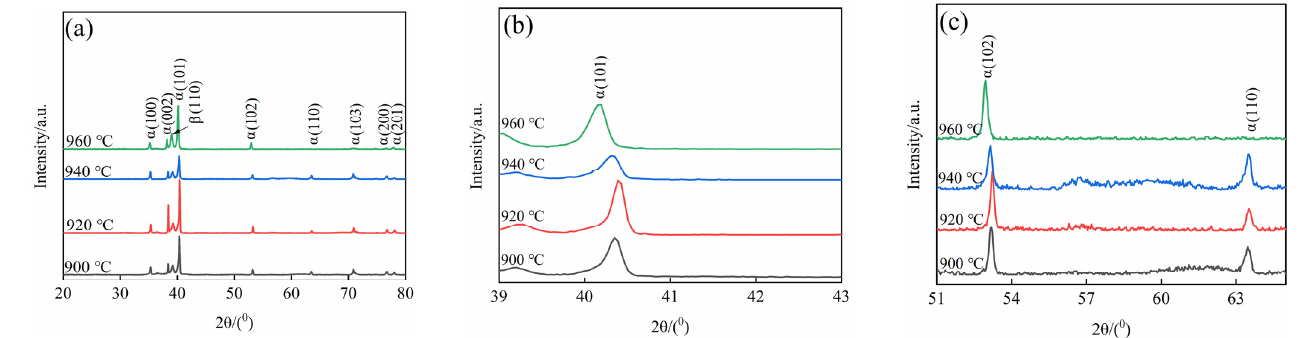
Figure 6. XRD diffraction patterns after BASC heat treatment: ( a ) Scanning angle (20~80°); ( b ) Scanning angle (39~43°); ( c ) Scanning angle (51~65°).